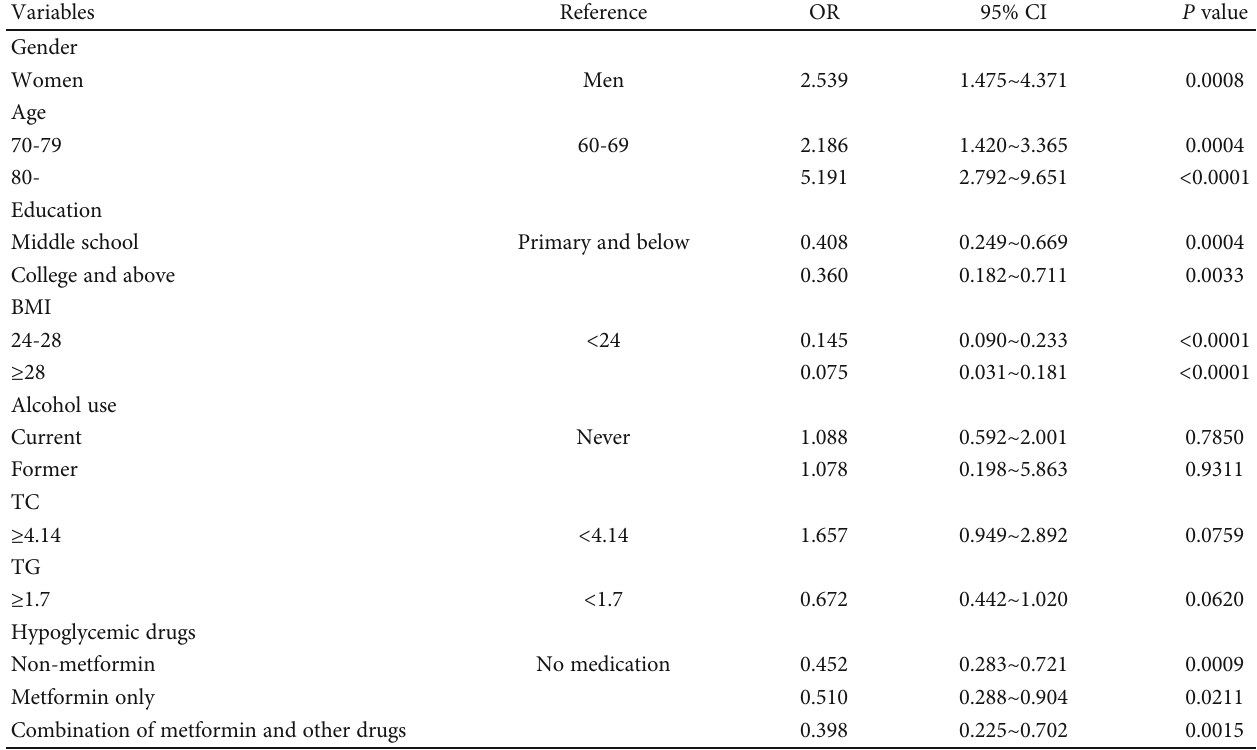
Table 3: The results of multivariate analysis of in fl uencing factors of sarcopenia in subjects.